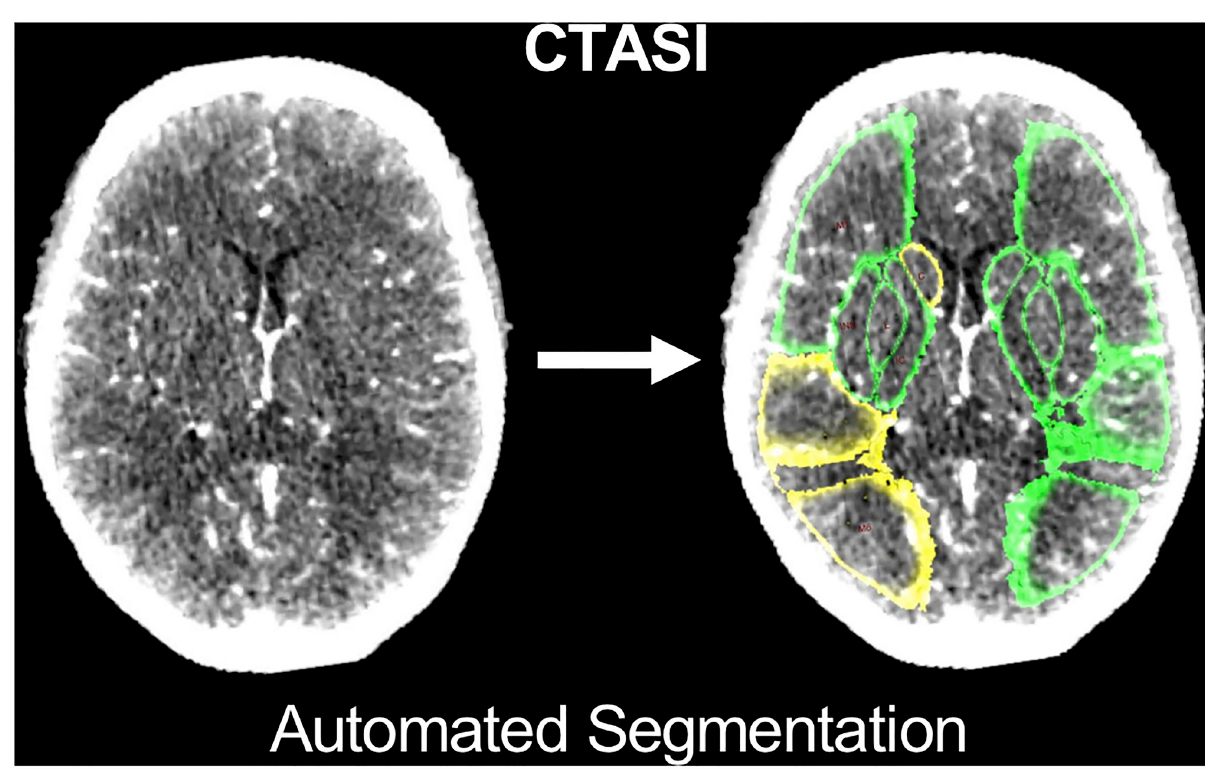
Fig 1. Segmentation of ASPECTS regions on CTASI. Abbreviations: ASPECTS, Alberta Stroke Program Early CT Score; CTASI, CT angiography source images; C, Caudate Nucleus; L, Lentiform Nucleus; C, Caudate; M1, M2 cortical regions of the ASPECTS. Colors indicate reduction in regional x-ray attenuation compared with the contralateral hemisphere (green = difference < 1 HU; yellow = difference � 1 and < 3 HU; red = difference > 3 HU).